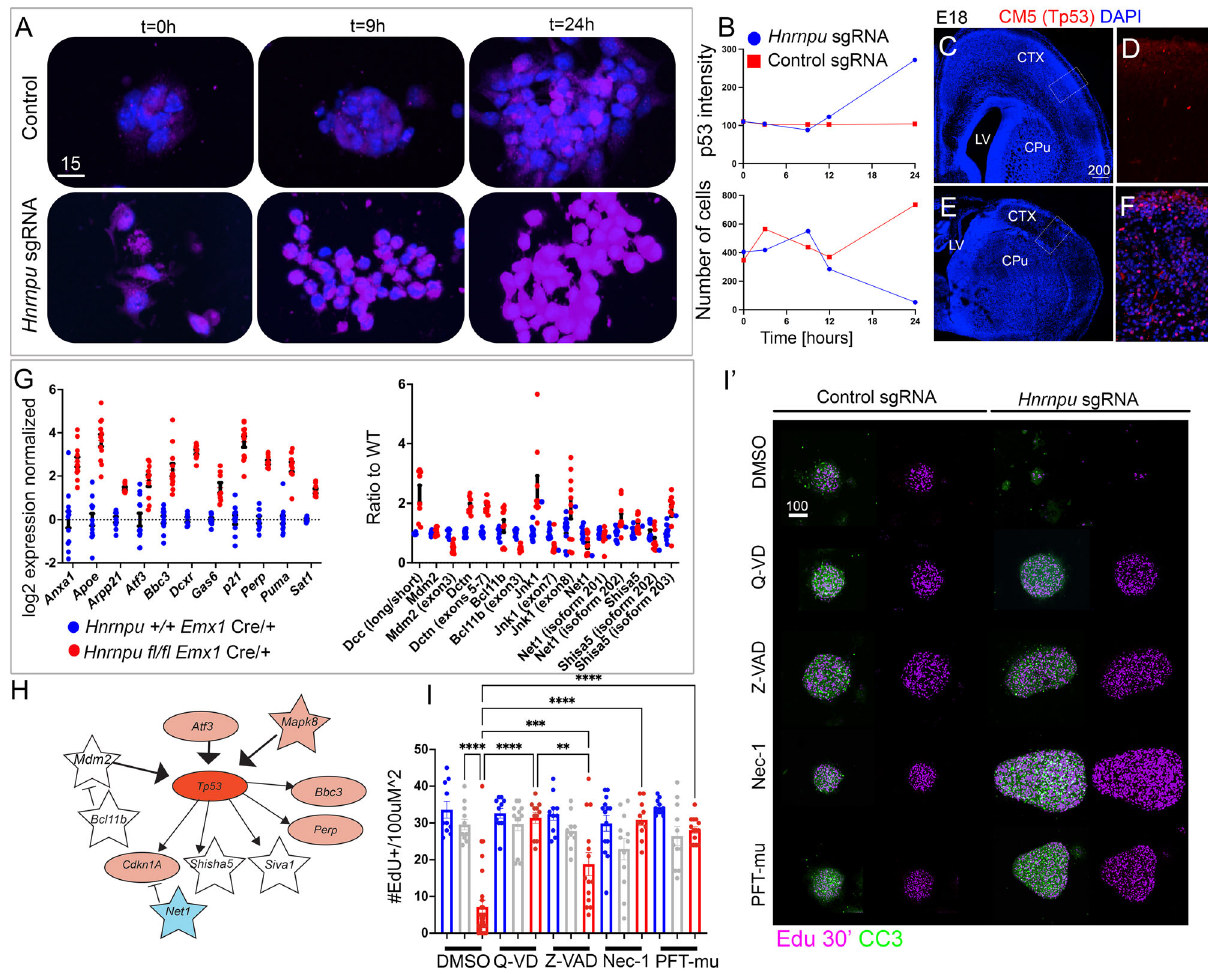
Fig. 4 Activation of TP53-mediated apoptotic pathway following Hnrnpu KO. A Time-dependent accumulation of TP53 (CM5 antibody) in neurospheres treated with control CRISPR/CAS9 plasmid (px330) or Hnrnpu sgRNA ’ s and plated at indicated time. Acquisition of the intensity of the CM5 signal was done in identical imaging parameters for all images. B Measurements of the dynamic accumulation of TP53. Cells were identi fi ed DAPI, and the average intensity in each spot was normalized to a non-speci fi c background (upper panel). The accumulative number of cells in all fi elds of view is plotted against time (lower panel). C – F Low magni fi cation images (Dapi, blue) of coronal sections (E18) of control ( Hnrnpu + / + Emx1 Cre/ + ) and mutant ( Hnrnpu fl / fl Emx1 Cre/ + )